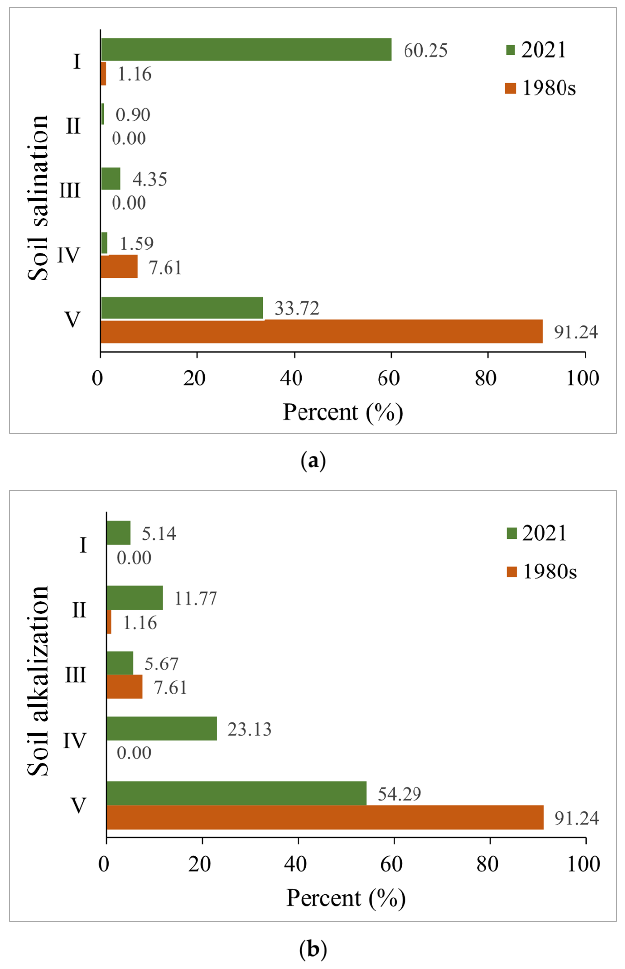
Figure 6. ( a ) Soil salinization and ( b ) soil alkalization variation under five levels from the 1980s to 2021.